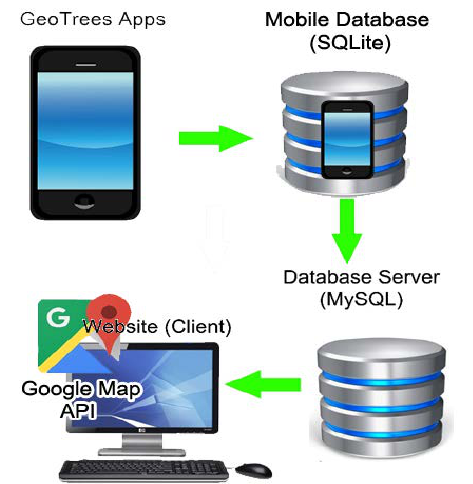
Figure 3. The workflow of data entry using GeoTrees mobile